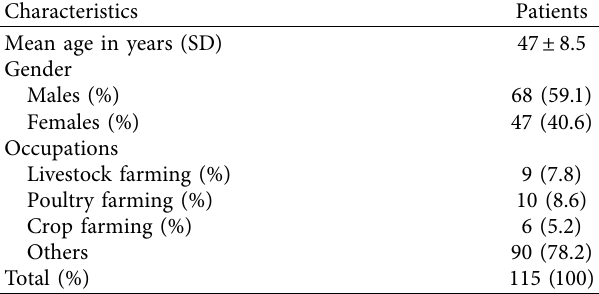
Table 1: Demographic characteristics of study population.